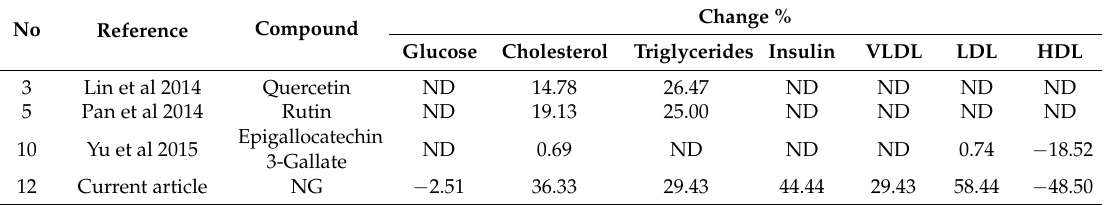
Table 3. Percentage changes of metabolic parameters induced by flavonoids on BDL